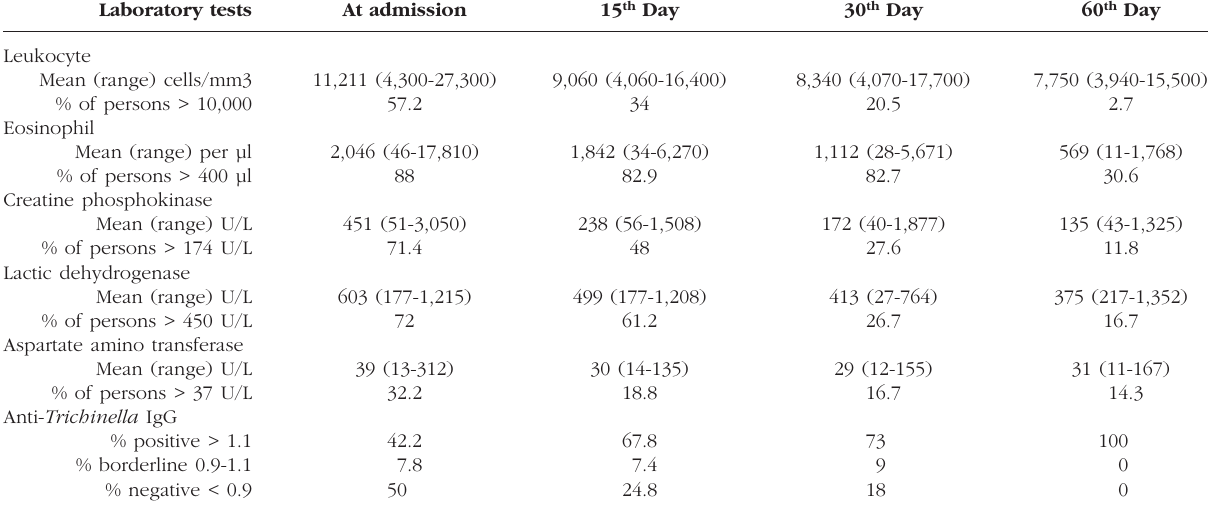
Table II. – Laboratory features of the confirmed cases of trichinellosis (n = 154) at the admission and 15, 30 and 60 days after.